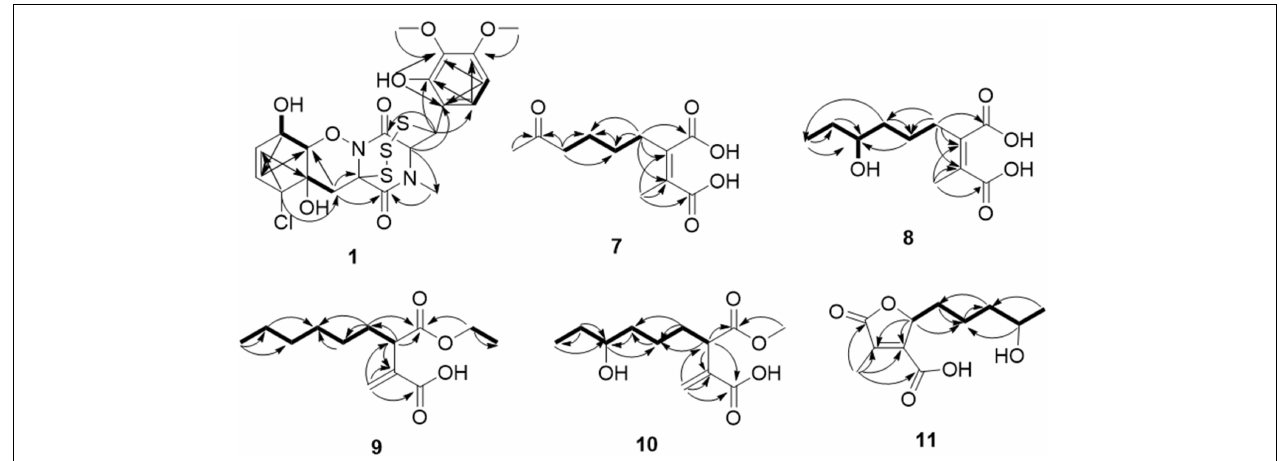
FIGURE 2 | Key HMBC (arrows) and COSY (bold lines) correlations of compounds 1 and 7 - 11 .